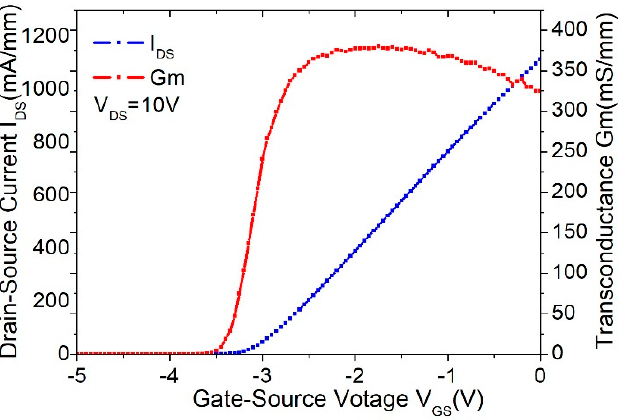
Figure 5. DC characteristic of the 2 × 20 μ m device without thick copper metallization.